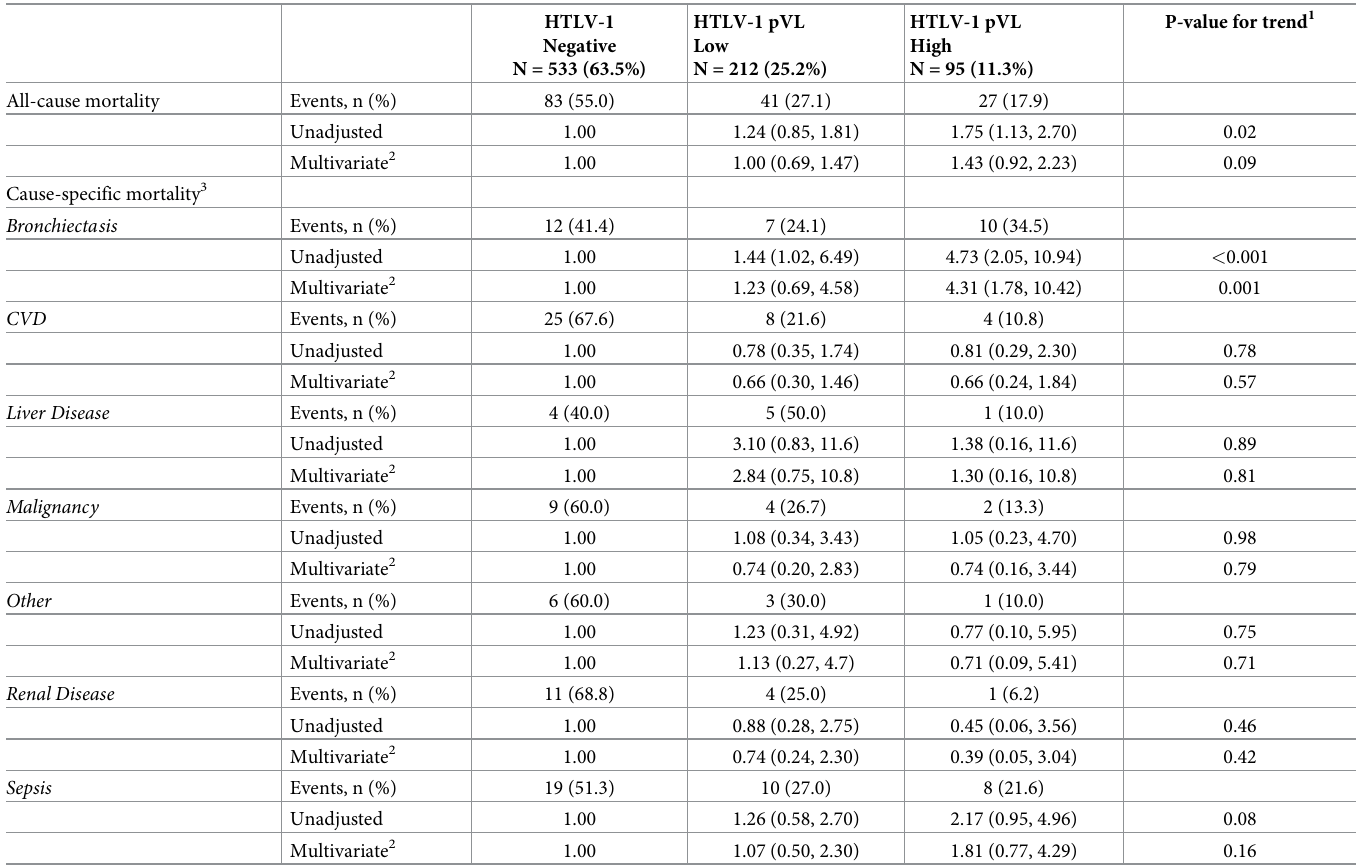
Table 6. Hazard ratios for all-cause and cause-specific mortality according to HTLV-1 proviral load status.